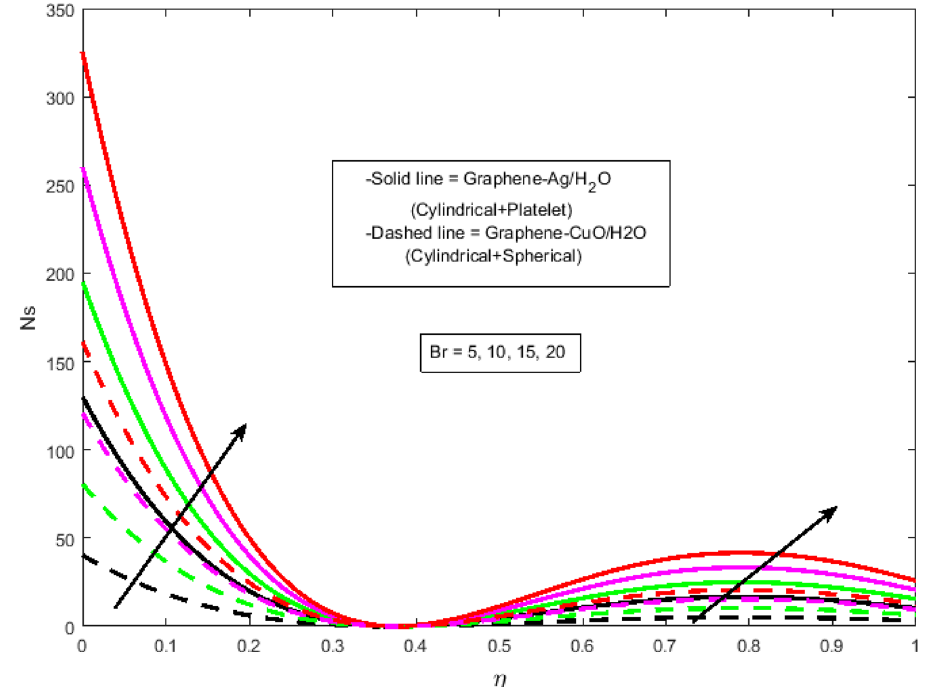
Figure 9. Effect of Br on Ns .